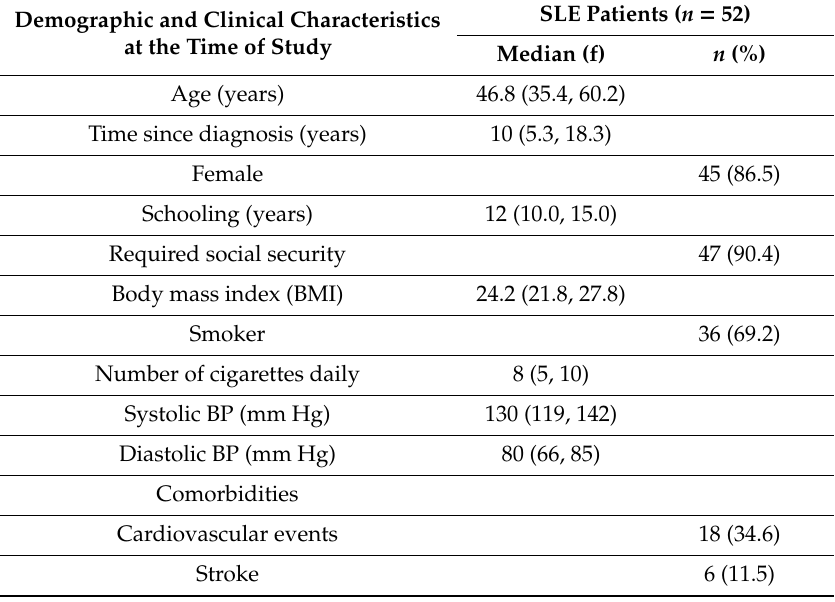
Table 1. Systemic lupus erythematosus (SLE) patient demographic and clinical characteristics at the time of